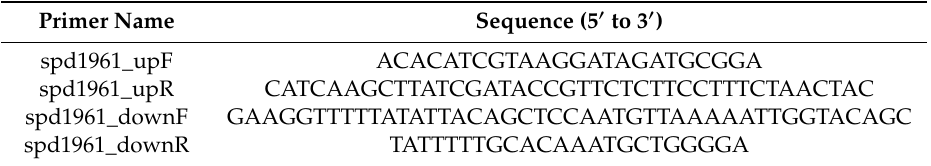
Table 1. Oligonucleotide primers for deletion of ulaR2 by splice overlap